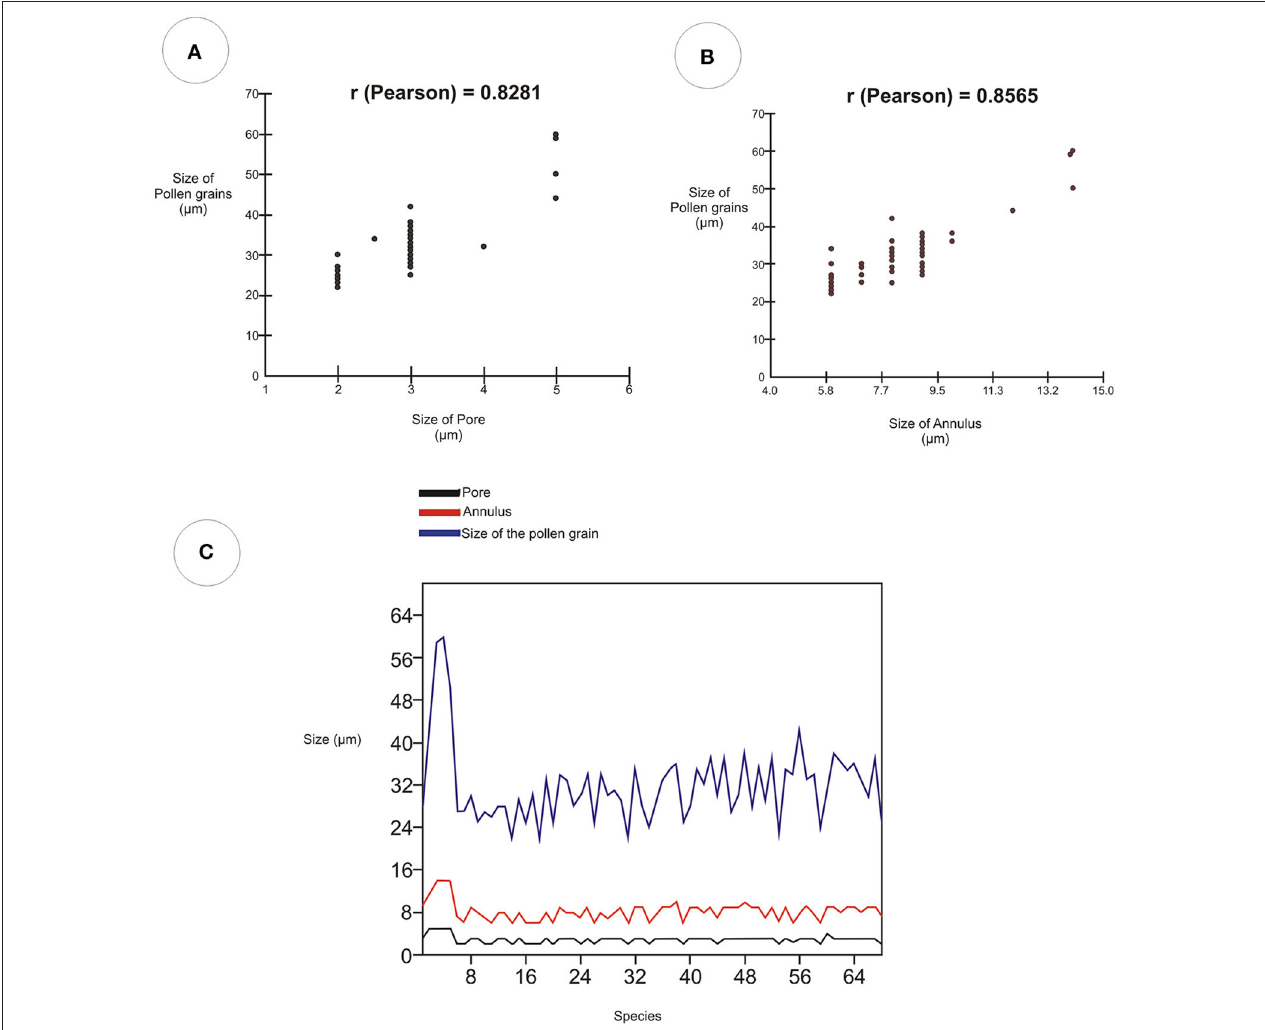
FIGURE 11 | Pearson correlation diagram showing the strength of the relationship between pore, annulus, and size of pollen grain for the 68 Poaceae species. (A) Correlation between the variable sizes of the pore and size of the pollen grain. (B) Correlation between the variable annulus sizes and the pollen grain sizes. (C) Linear chart of the values of the diameters of the pores, annulus, and pollen